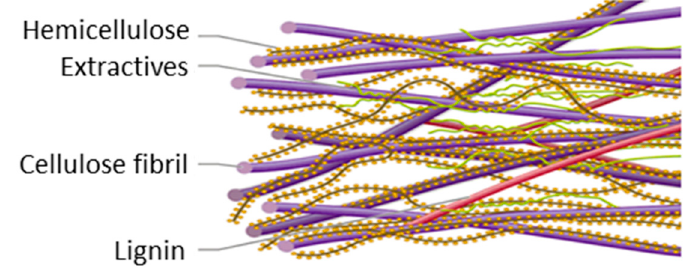
Figure 2. Illustration of the distribution of the lignin and carbohydrates in the fiber surface.